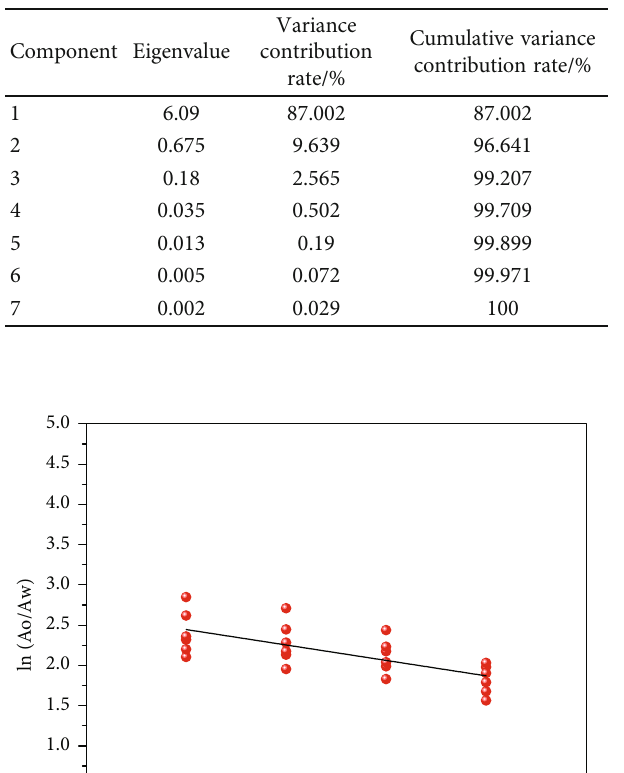
Table 4: Results of PCA for water cut.